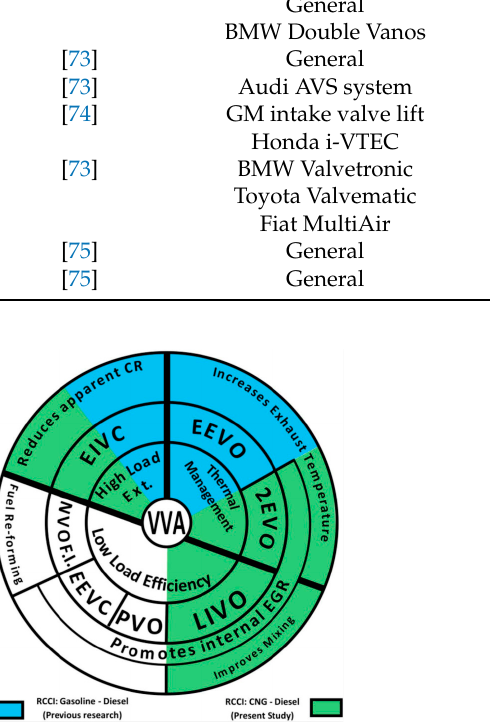
Table 2. The benefits of various valve systems for fuel economy [37]. Refs.